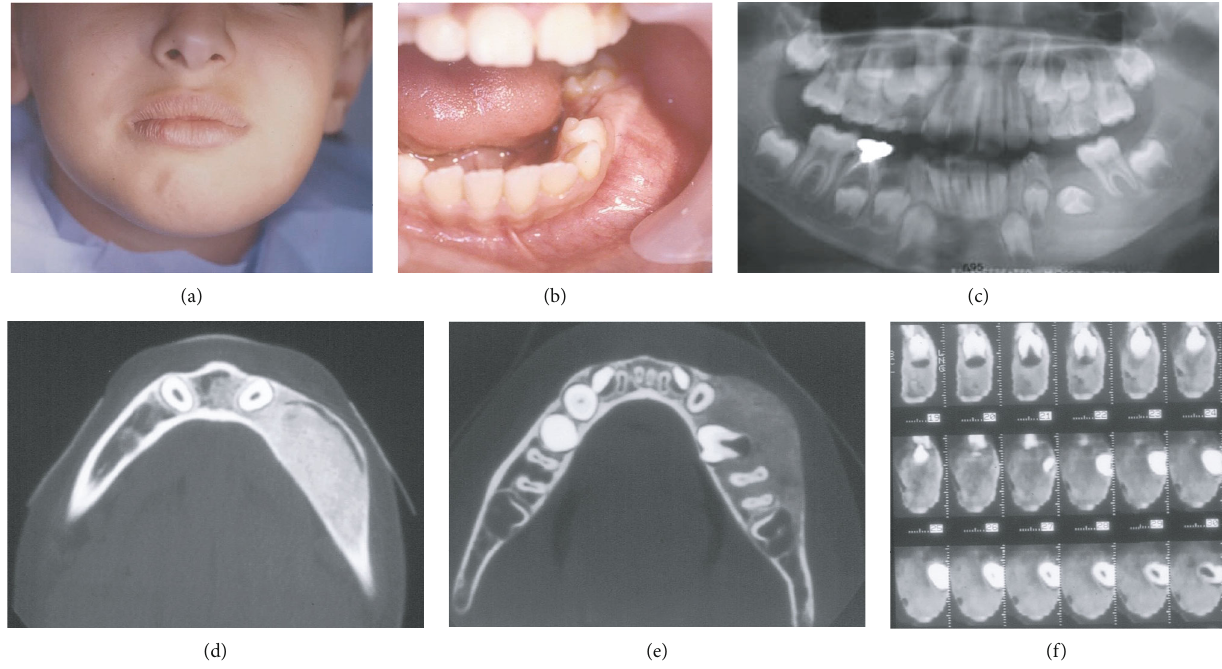
Figure 1: (a) Facial asymmetry on the left side. (b) Swelling in the buccal side of the mandible. (c) Panoramic X-ray showing the radiopaque image englobing the dental germ of the permanent second premolar. (d) The course of the mandibular canal displaced buccally is shown on the axial image of the CBCT. (e) Axial image of the CBCT showing the expansion of the body of the mandible. (f) Para-axial images of the CBCT revealed the ossi fi cation of the lesion and the positions of the retained dental germ and the mandibular